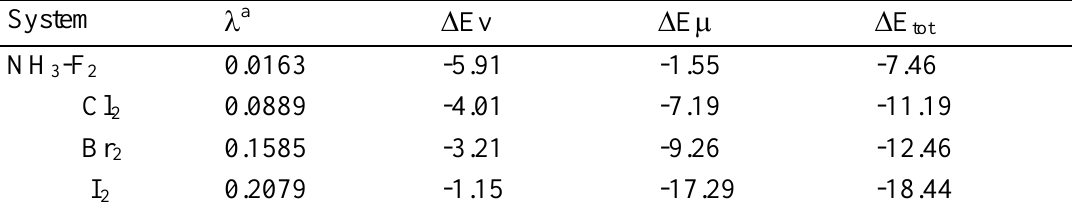
Table 3 : The interaction energies for the Charge transfer complexes (Energies in kcal/mol) a